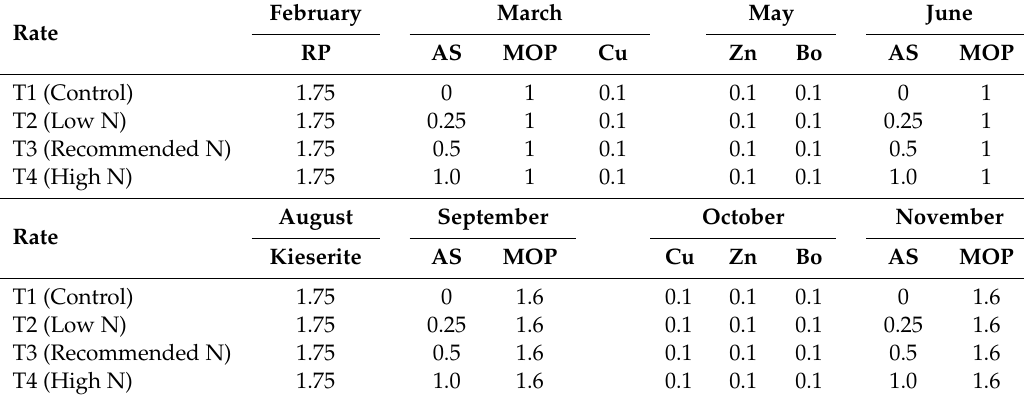
Table 2. Fertilization schedule from 2010 to 2017 (kg palm − 1